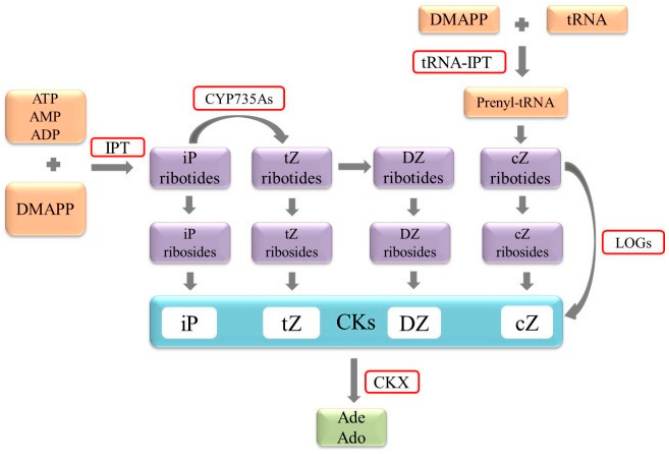
Figure 1. Simplified model of cytokinin biosynthesis and decomposition pathways.